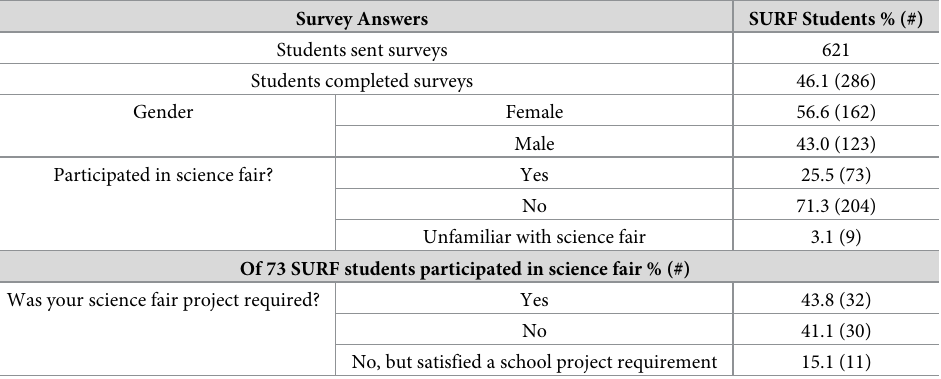
Table 1. SURF student demographics and science fair